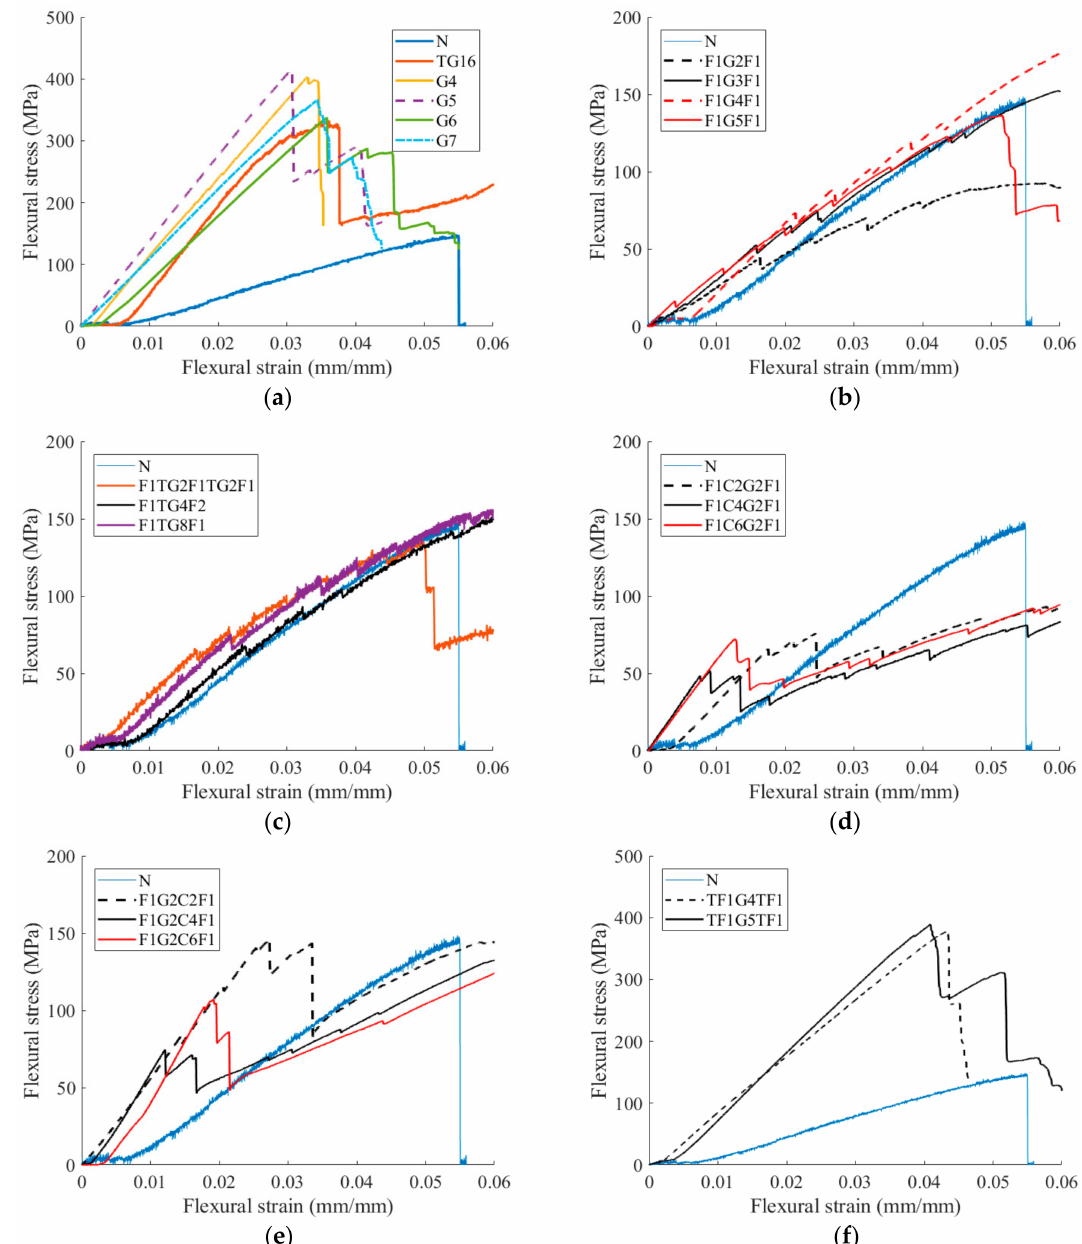
Figure 5. Stress-Strain (Deformation) Relation: ( a ) N: Rein; ( b ) G: Glass Fiber; ( c ) FGF: Felt-Glass Fiber-Felt; ( d ) FCGF: Felt-Carbon Fiber-Glass Fiber-Felt; ( e ) FGCF: Felt-Glass Fiber-Carbon Fiber-Felt; and ( f ) TFGTF: Thin Felt-Glass Fiber-Thin